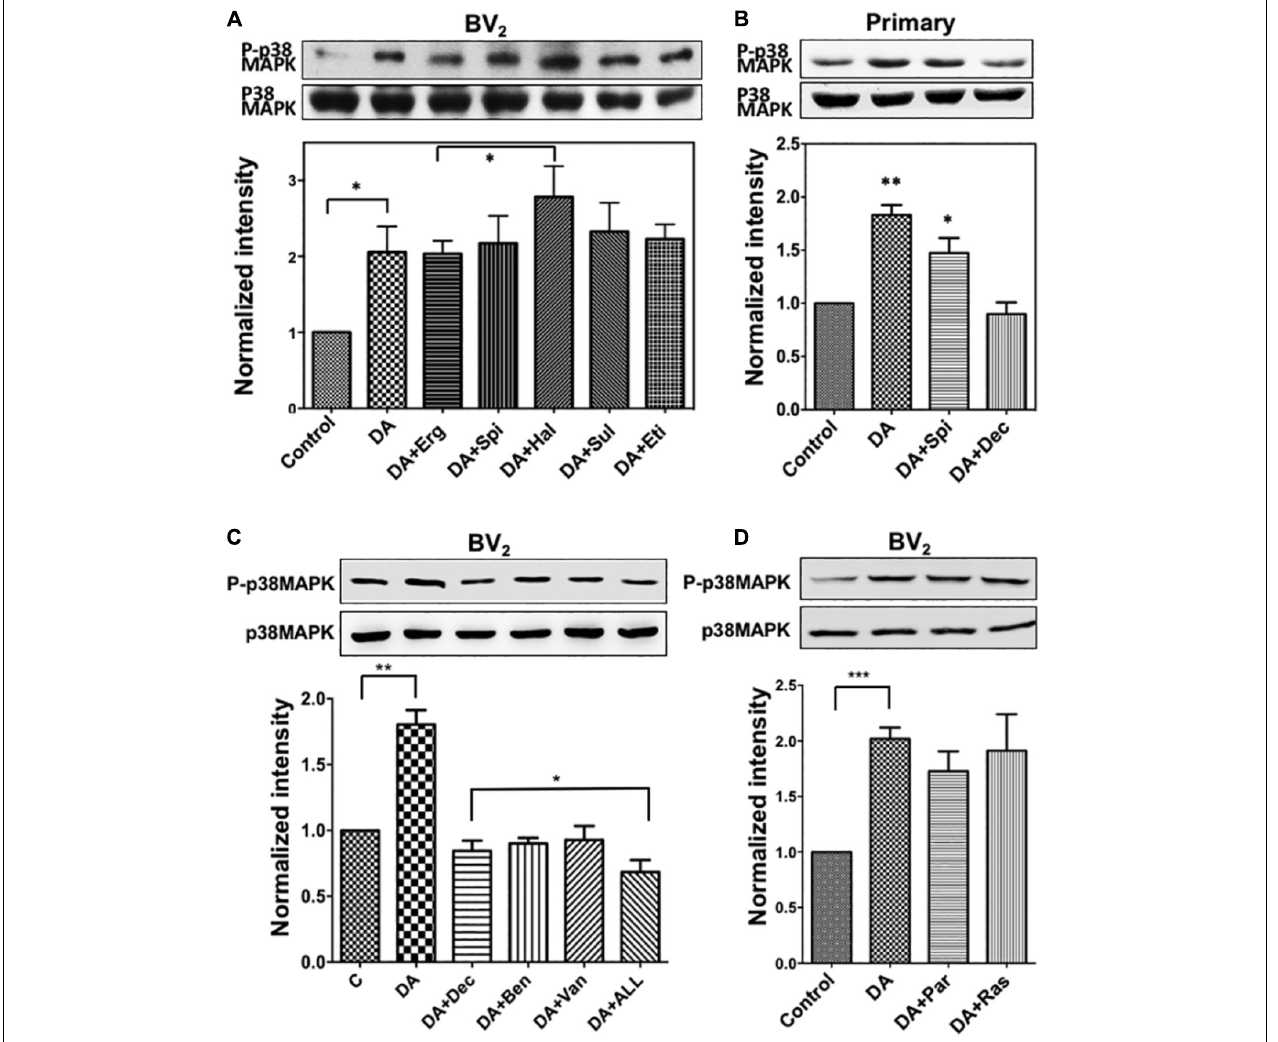
FIGURE 5 | (A) Activation of p38MAPK by DA in resting microglia cannot be blocked with DA receptor antagonists. Resting BV 2 microglia cells were pre-treated with various DA receptor antagonists (2 µ M each, specificity of each antagonist was mentioned in section “Materials and Methods”) for 10 min and then treated with 2 µ M DA for 30 min. Activation of p38MAPK was measured as fold increase to the control using immunoblotting with the anti-phospho-p38MAPK antibody. Values are means ± standard error of five independent experiments (ANOVA: ∗ P < 0.05). (B) Activation of p38MAPK by DA in primary microglia. Cultured primary microglia cells from mouse brain were pre-treated with spiperone and decynium and treated with 2 µ M DA for 30 min. Activation of p38MAPK was assessed by immunoblotting (ANOVA: ∗ P < 0.05, ∗∗ P < 0.01 compared to control). (C) p38MAPK activation by DA can be inhibited by selective DAT blockers (benztropine and vanoxerine; 2 µ M each) and PMAT blocker (Decynium; 2 µ M). Combination of DAT and PMAT blockers further inhibited the activation of p38MAPK (ANOVA: ∗ P < 0.05, ∗∗ P < 0.01). (D) Inhibitors of monoamine oxidase did not show any significant effect on p38MAPK activation by DA. Neither pargyline nor